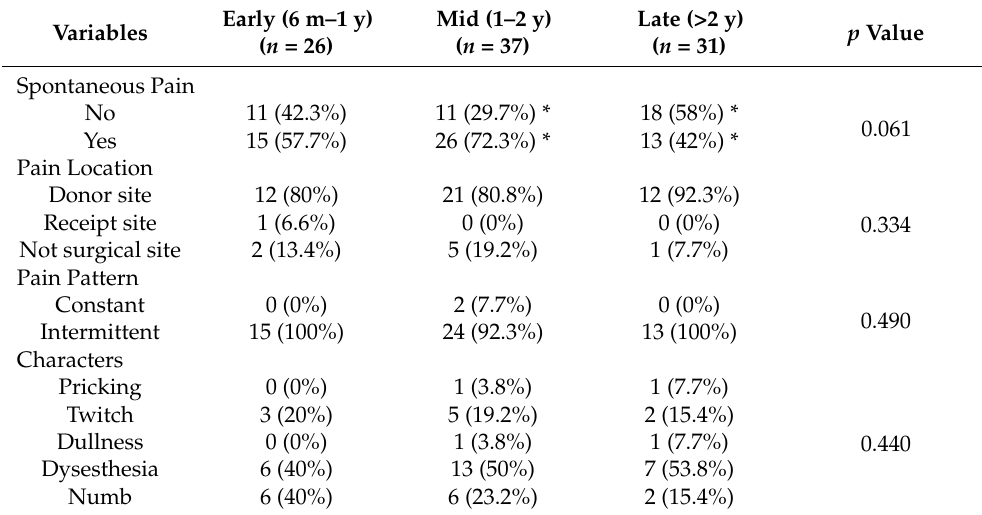
Table 5. Pain characteristics at each time interval following anterolateral thigh flap